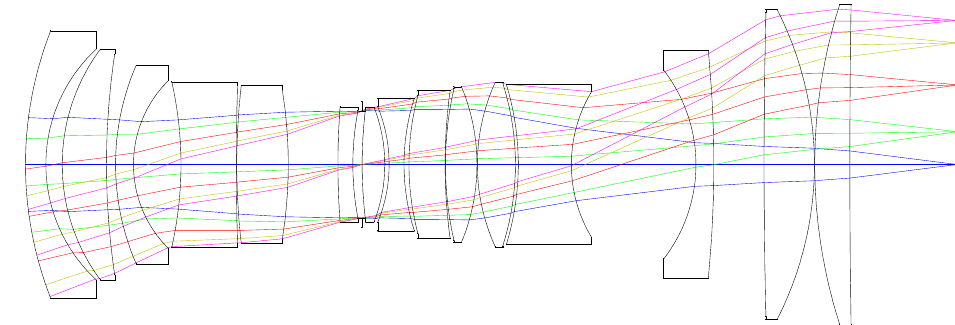
Figure 6. Optical configuration of the initial system.